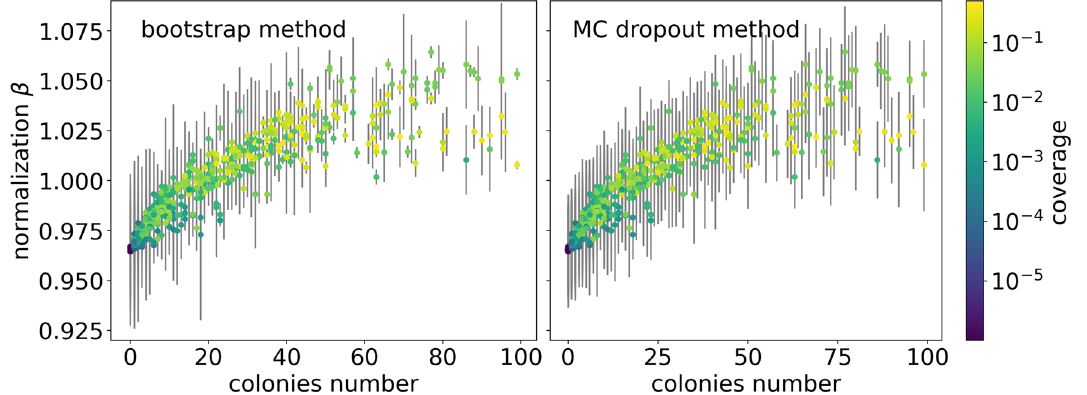
Figure 8. Dependence of the normalization parameter β on the number of colonies. Uncertainties of the β parameter calculated using bootstrap method (left) and MC dropout (right). Results for the test subset.